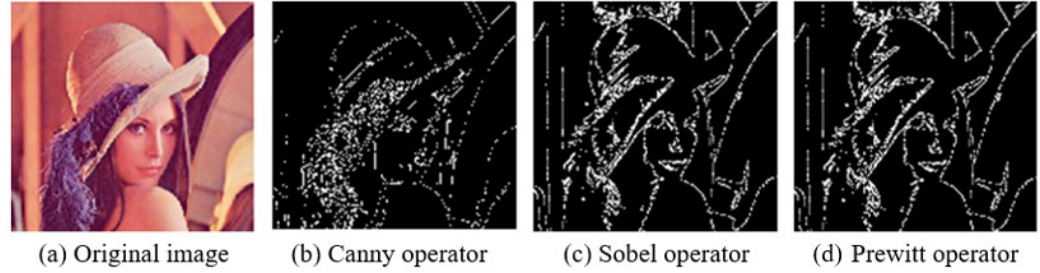
Figure 3. Edge detection results: ( a ) Original image; ( b ) Canny operator; ( c ) Sobel operator; ( d ) Prewitt operator.